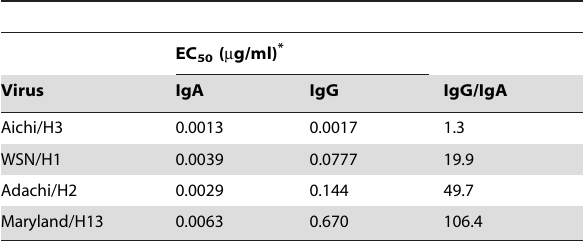
Table 1. Comparison of binding abilities of S139/1 IgA and IgG to influenza A viruses.